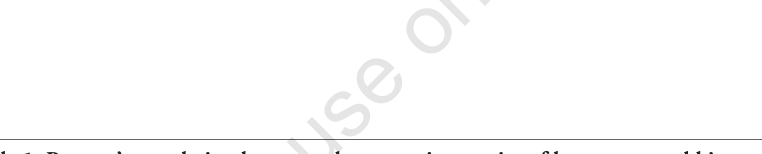
Table 1. Pearson’s correlation between phagocytosis capacity of hemocytes and biomark- ers (COX and Vtg) in Mytilus edulis . Phagocytosis COX